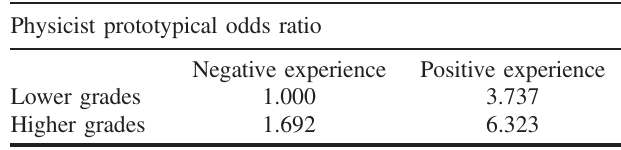
TABLE IV. Female physicist prototypical odds ratio. Higher grades denote an A in undergraduate physics and lower grades denote a B. Negative and positive experiences are in reference to undergraduate